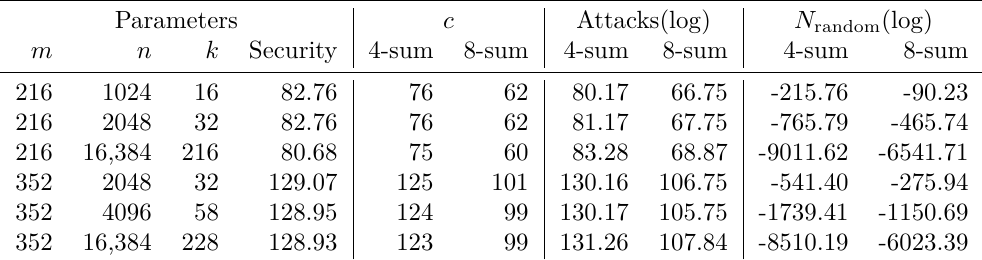
Table 2: Our distinguishing attack complexity corresponding to a few selected sets of parameters for 80-bit and 128-bit security of Firekite’s stream cipher.